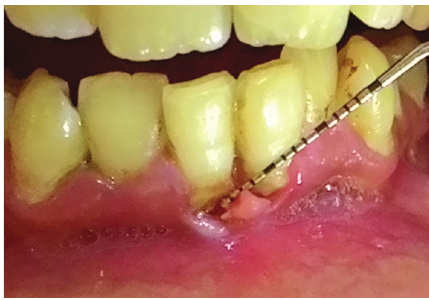
Figure 3: Case 3. Gingival recession due to scratching with finger- nail and sharp objects in relation to teeth #31 and